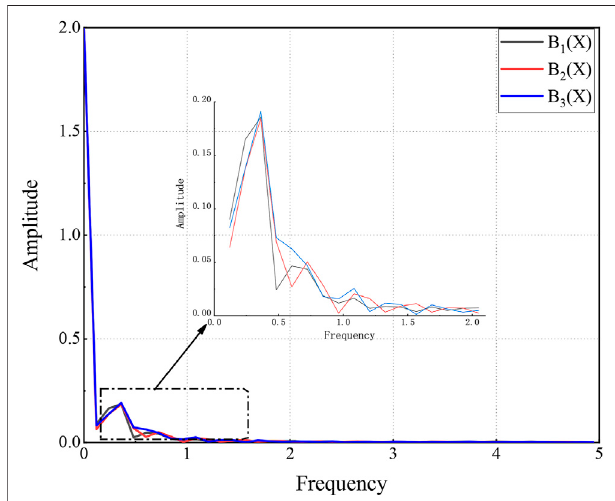
FIGURE 13 | Far- fi eld surge time-history curves.